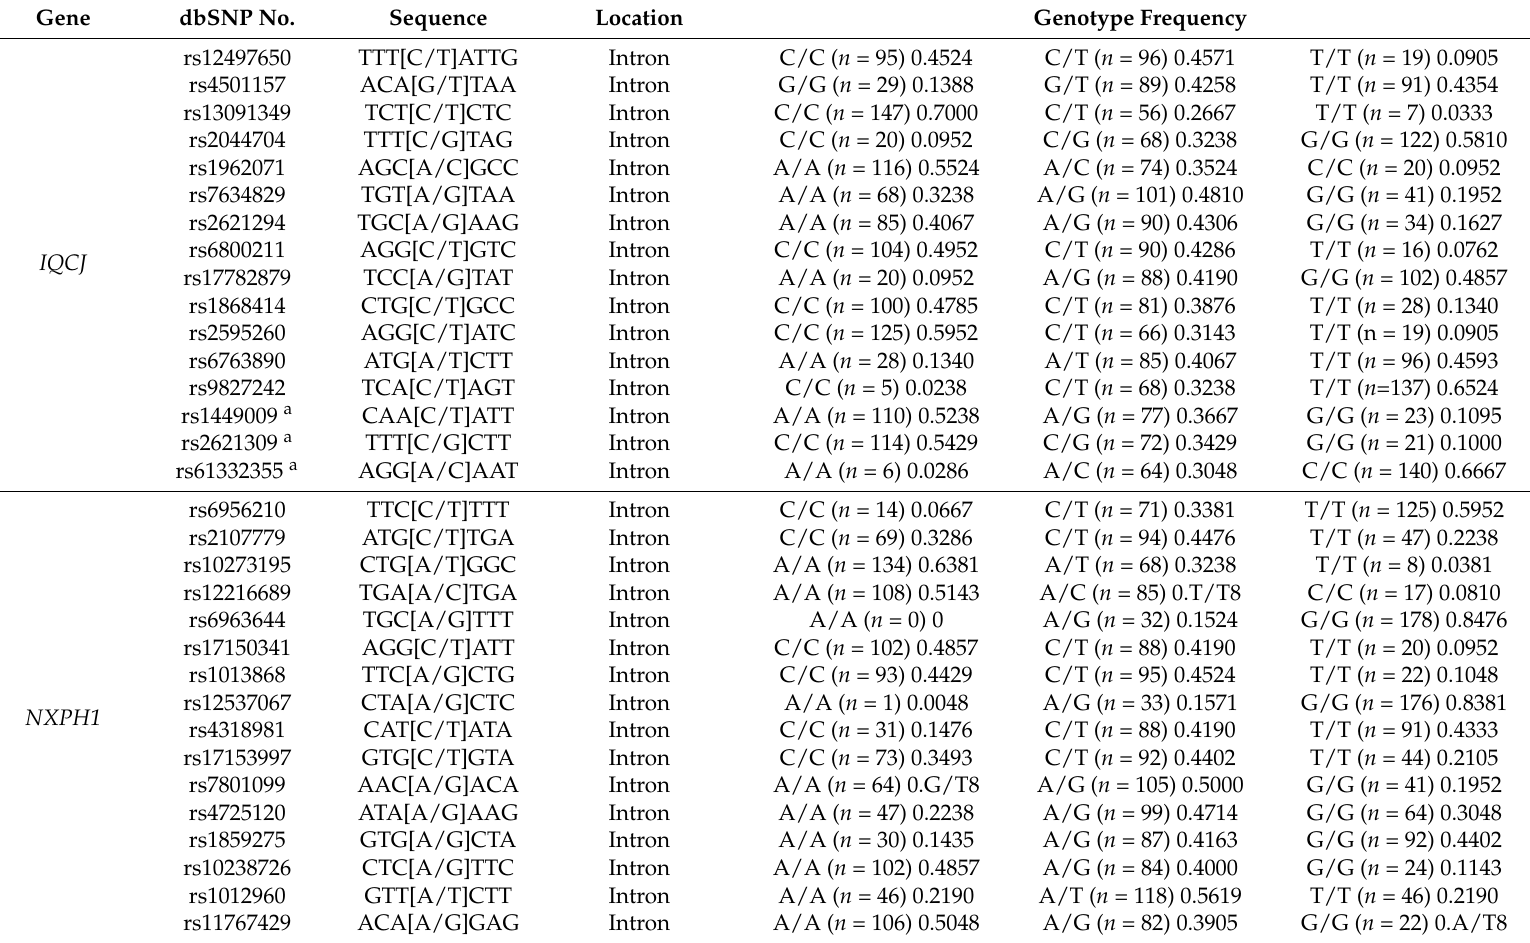
Table 2. Selected polymorphisms in candidate genes from the genome-wide association study (GWAS) of the Fatty Acid Sensor (FAS) study ( n = 210 individuals).